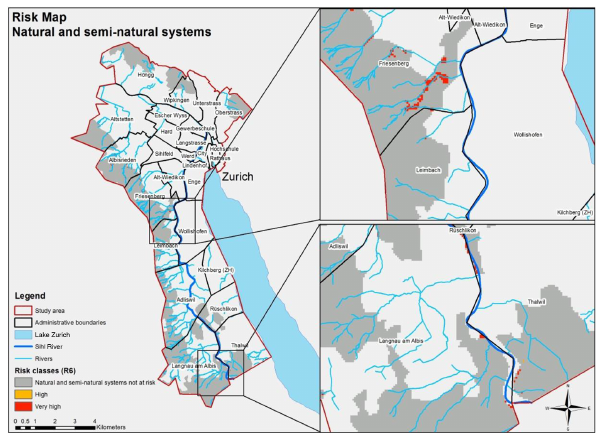
Figure 11. Relative risk map for cultural heritage (left) with two specific areas